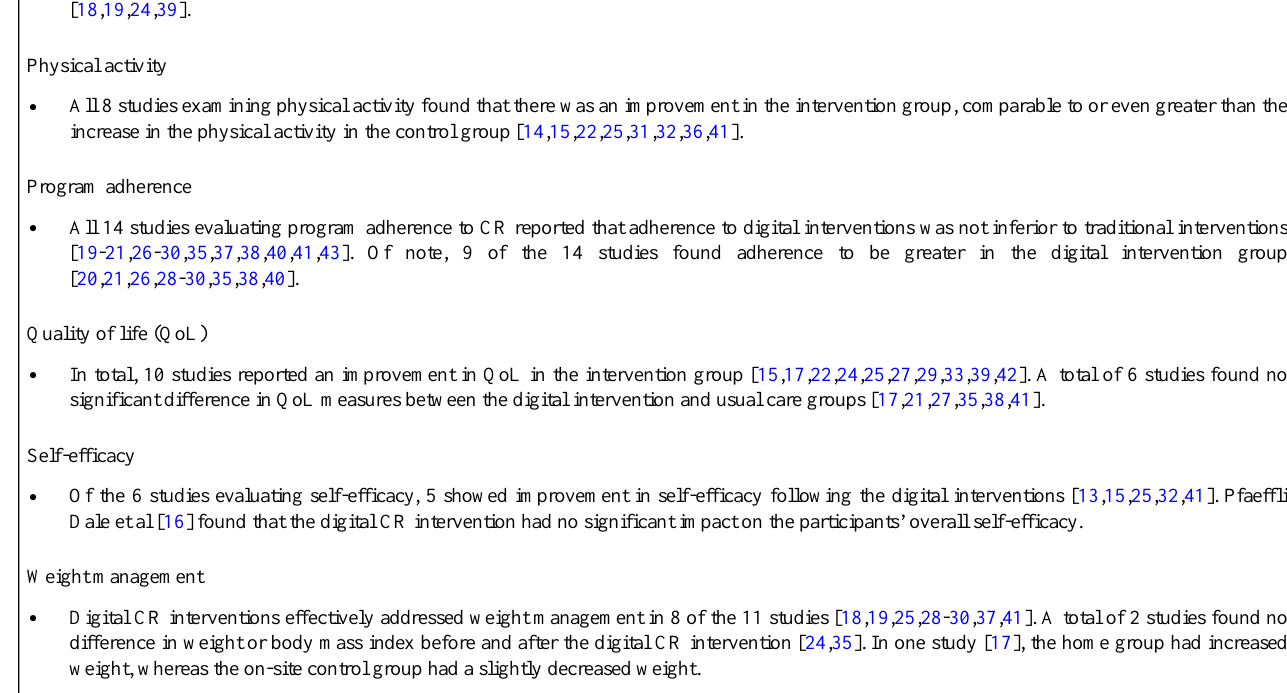
Textbox 2. Summary of findings by thematic outcomes. Blood glucose